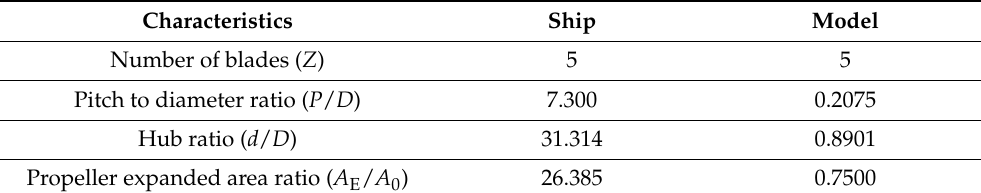
Table 2. The main characteristics of the model and full-scale propeller [35].